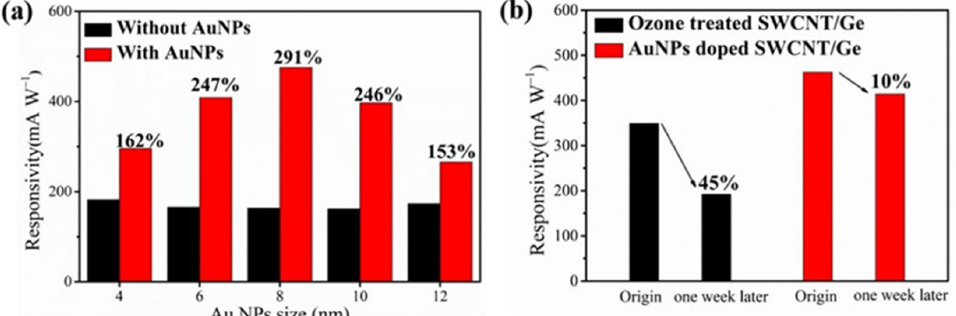
Figure 5. The doping effect of particle size and stability of the AuNPs-doped SWCNT/Ge photodetector. ( a ) The comparison of the responsivity of the SWCNT/Ge photodetector before and after deposition with various AuNPs particle sizes. ( b ) Stability of the Au-doped and ozone-treated SWCNT/Ge photodetector .